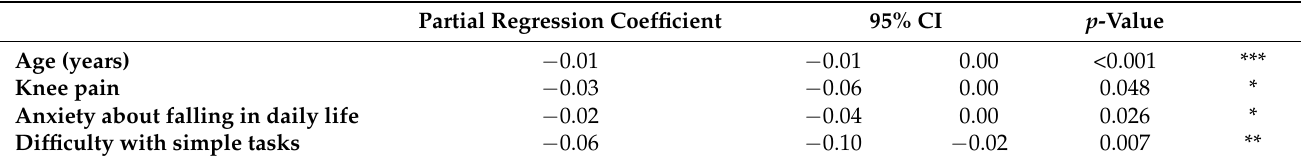
Table 3. Determinants of low two-step test scores (<1.3) ( n =